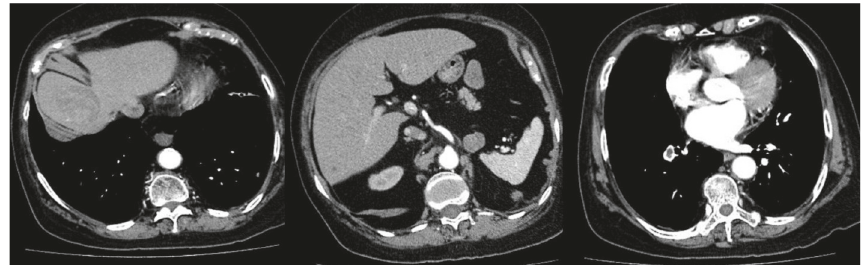
Figure 7: CT abdomen of Patient B on 30 December 2016. (a) Presence of liver metastasis. (b) Nodule at left adrenal bed and peritoneal nodule posterior to spleen. (c) Right descending pulmonary artery embolism.